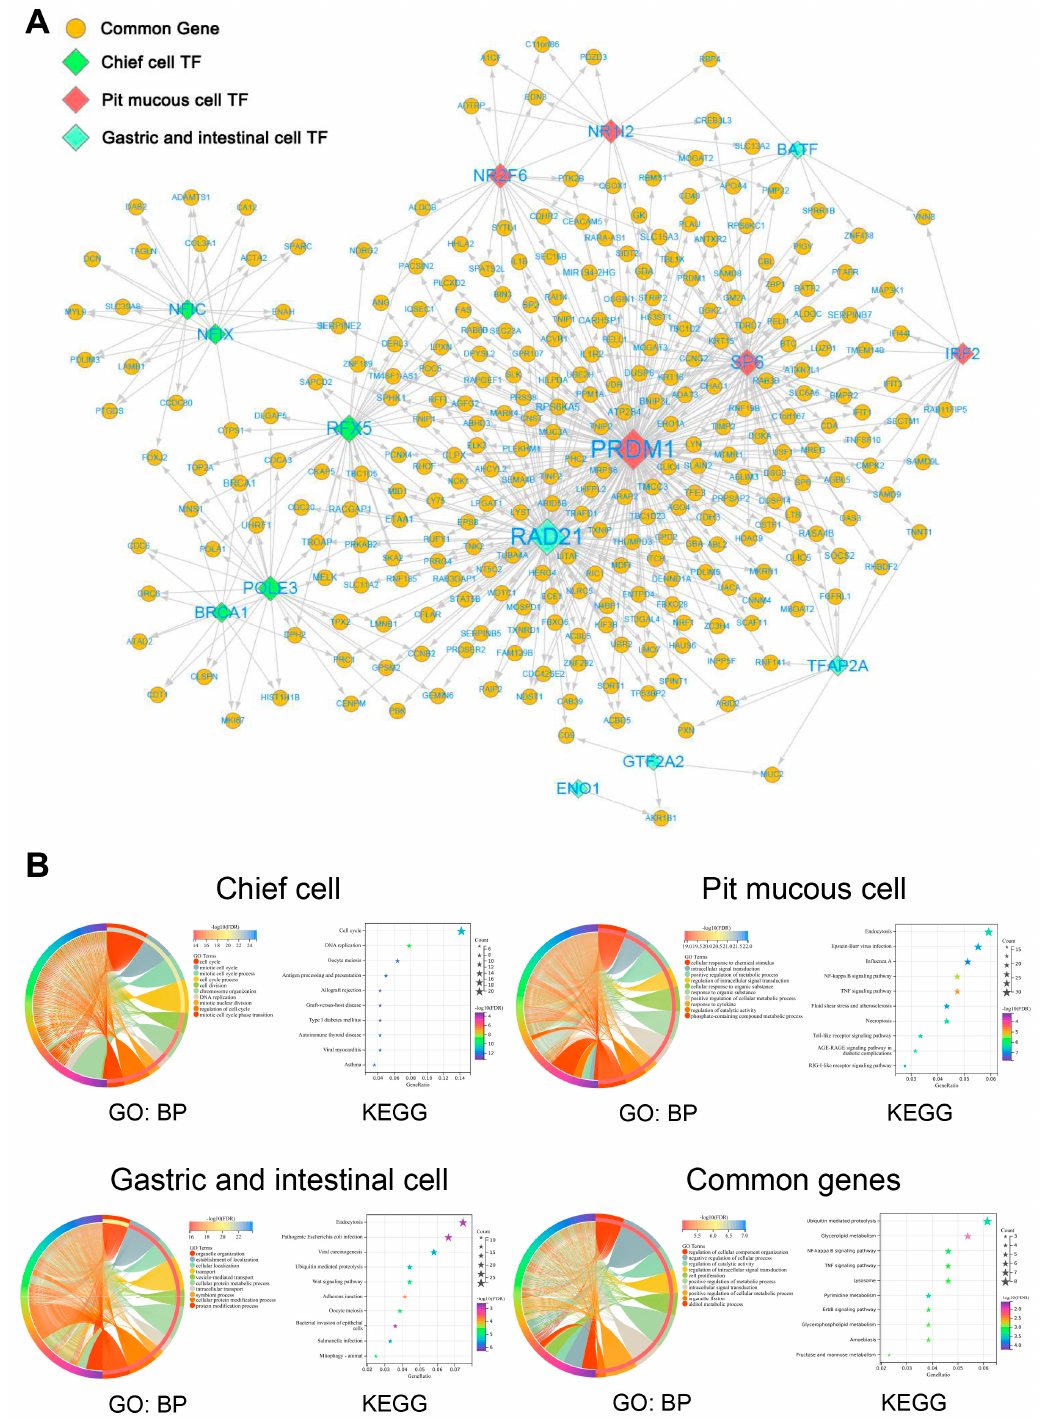
Figure 10. The TF-gene regulatory network of malignant epithelial cells. ( A ) Network showing the top 5 TF and their regulated genes in three subtypes of malignant epithelial cells. ( B ) Chord and bubble plots show the functional enrichment results of the top 5 TF regulated genes in three subtypes of malignant epithelial